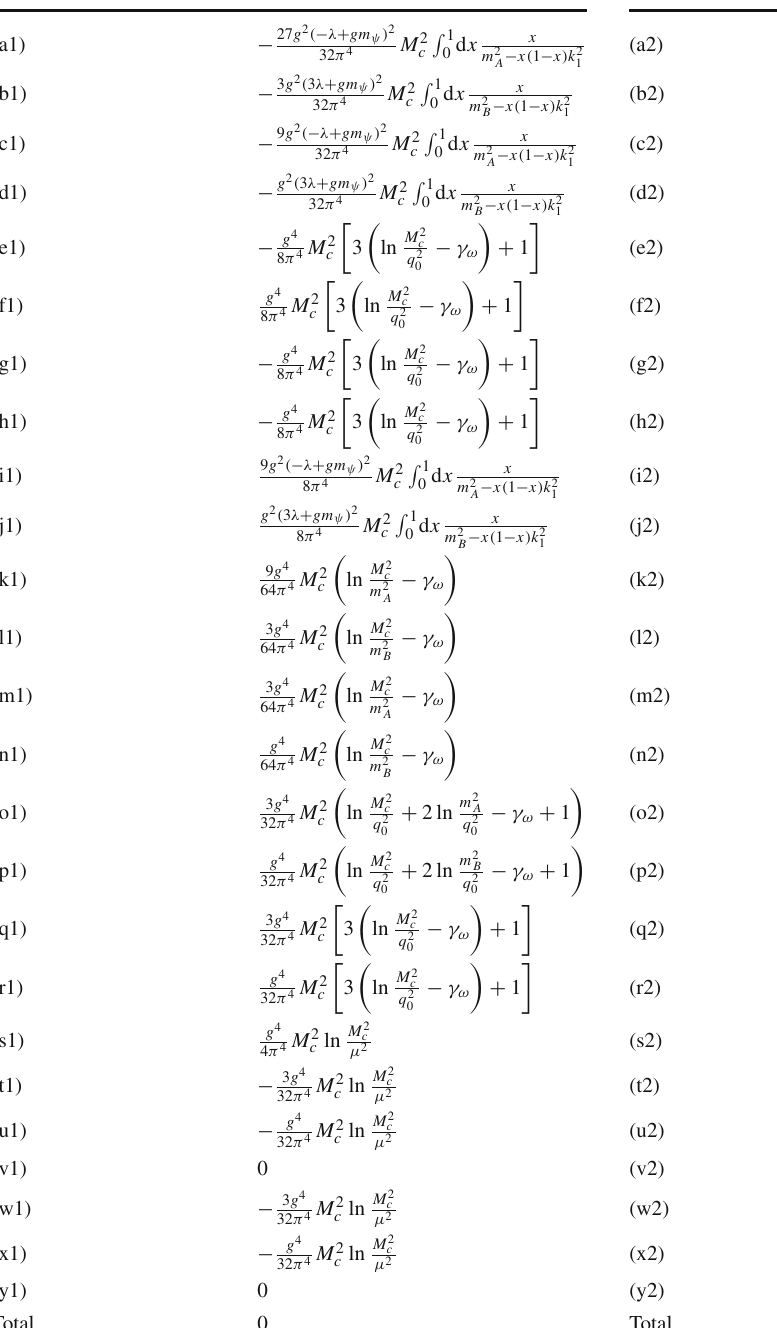
Table 3 Quadratic contributions in the two-loop self-energy diagrams of pseudoscalar particle B Diagram Quadratic